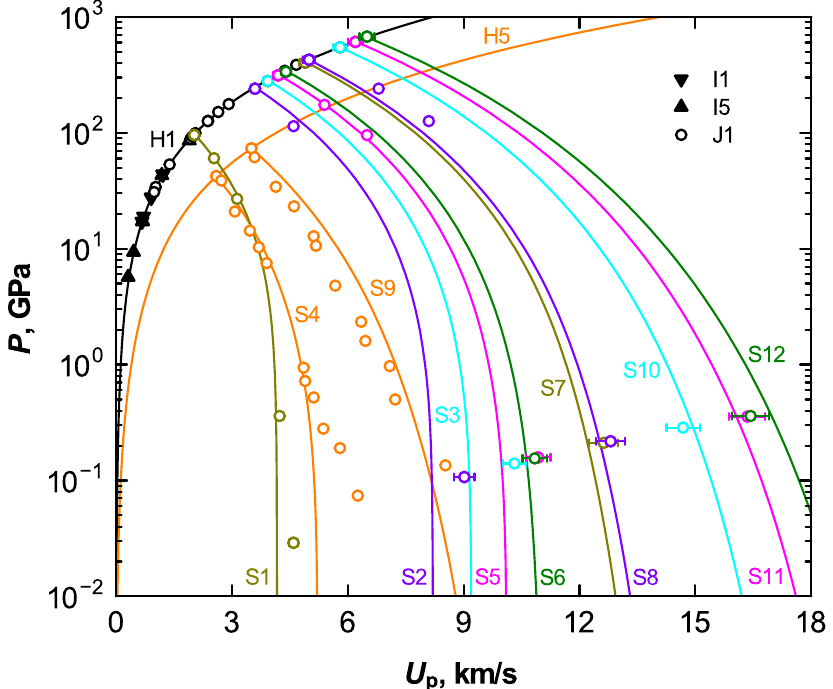
Figure 5. Shock adiabats (H1 and H5) and isentropes of unloading of the shock-compressed bismuth samples of different initial densities (S1 to S12): solid lines—results of calculations using the present model (shock adiabats H1 and H5 correspond to the initial density of the solid and porous samples ρ 00 = 9.8 and 4 g/cm 3 ); markers—experimental data (I1—[55]; I5—[59];